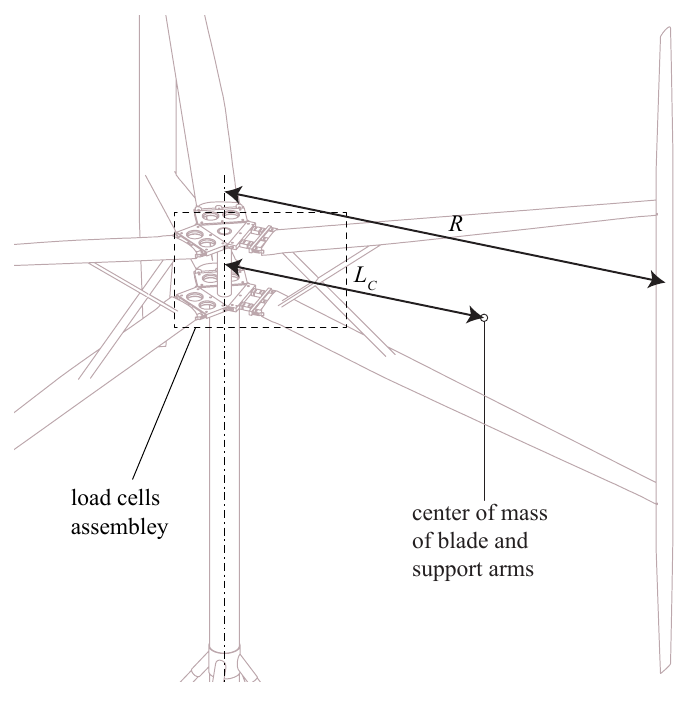
Figure 2. Load cells installed on the VAWT.